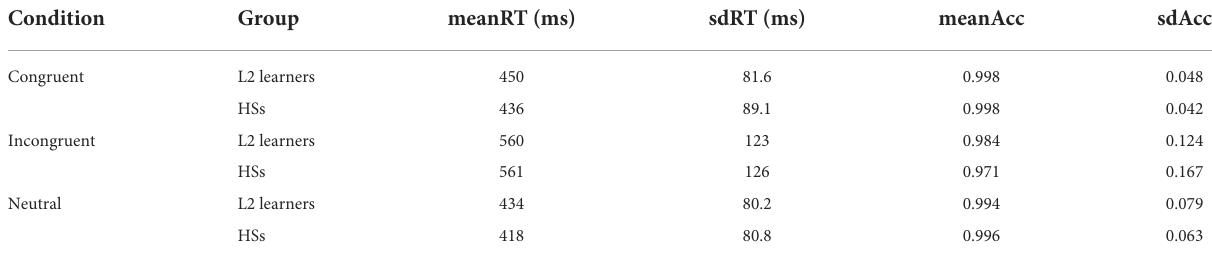
TABLE 1 Summary of the behavioral analysis (mean Reaction Times and Accuracy) for the L2 learners ( n = 32) and HSs ( n = 28) for the three different conditions (congruent, incongruent, and neutral) in the Flanker task.